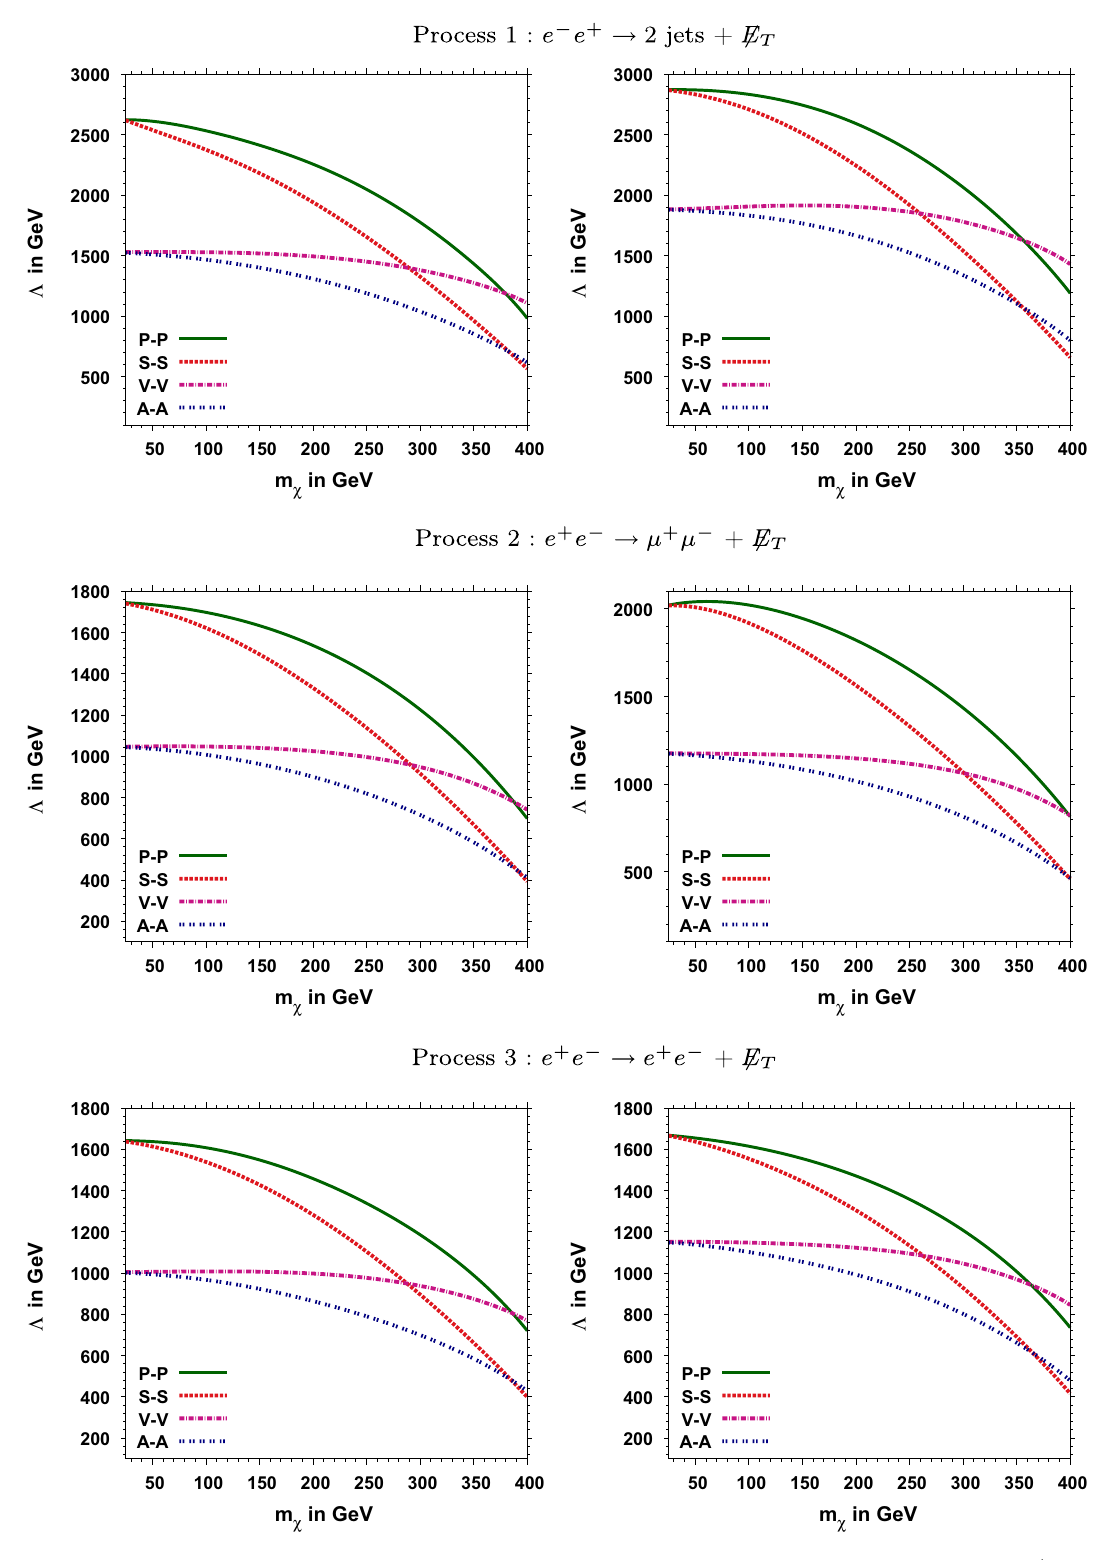
Fig. 8 99% confidence level contours in the m χ and Λ plane from the χ 2 analyses of the respective final visible states at collider parameter choice given in the third and the fourth column of Table 1. The contours at the left correspond to the unpolarised beam